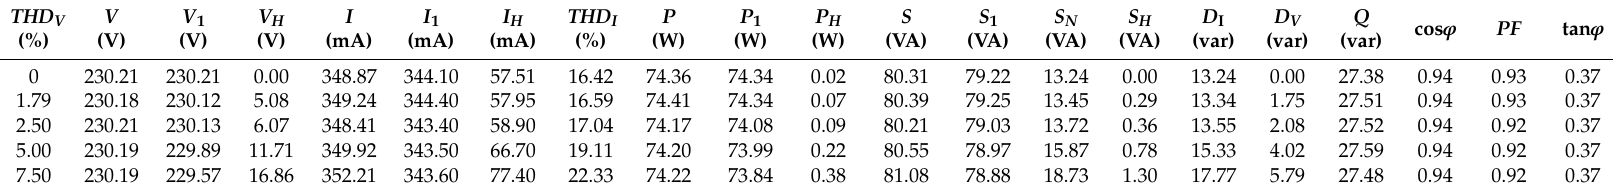
Table 6. Summary of measured and calculated values of electrical parameters of the LED2 luminaire at a change in the level of deformation of the supply